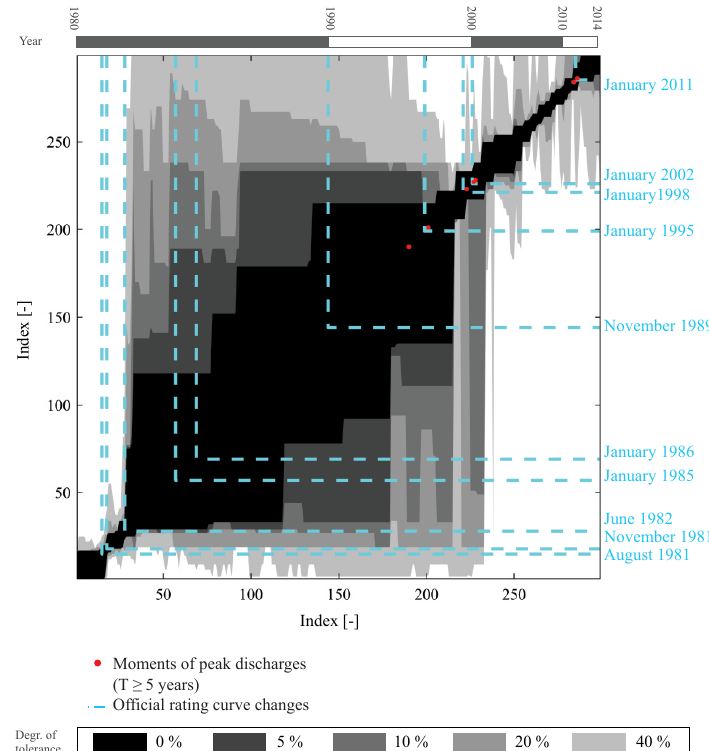
Figure 8. Combined BReach t_2s plot (all data) for Aarschot. For each index on the x axis the gray area indicates the span between the index of the maximum left reach (under the bisector) and the maximum right reach (above the bisector). Each gray tint represents a different degree of tolerance (i.e., percentage of data points allowed to have nonacceptable model results).